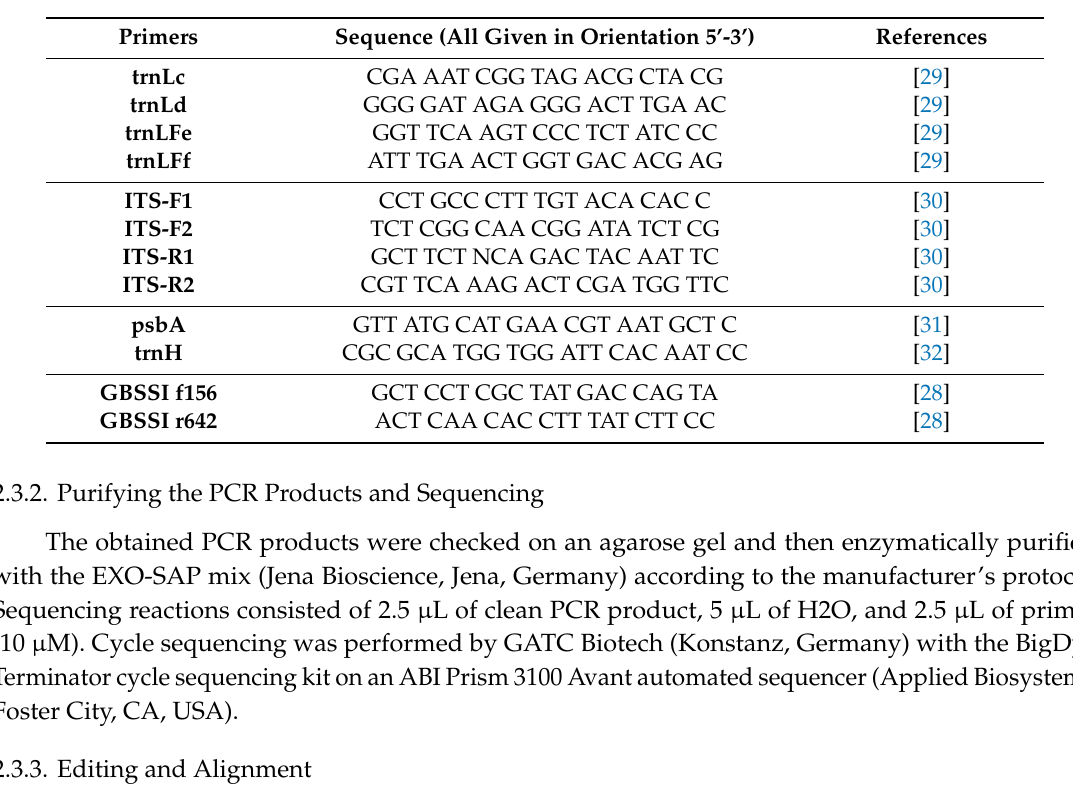
Table 3. Primers used for PCR